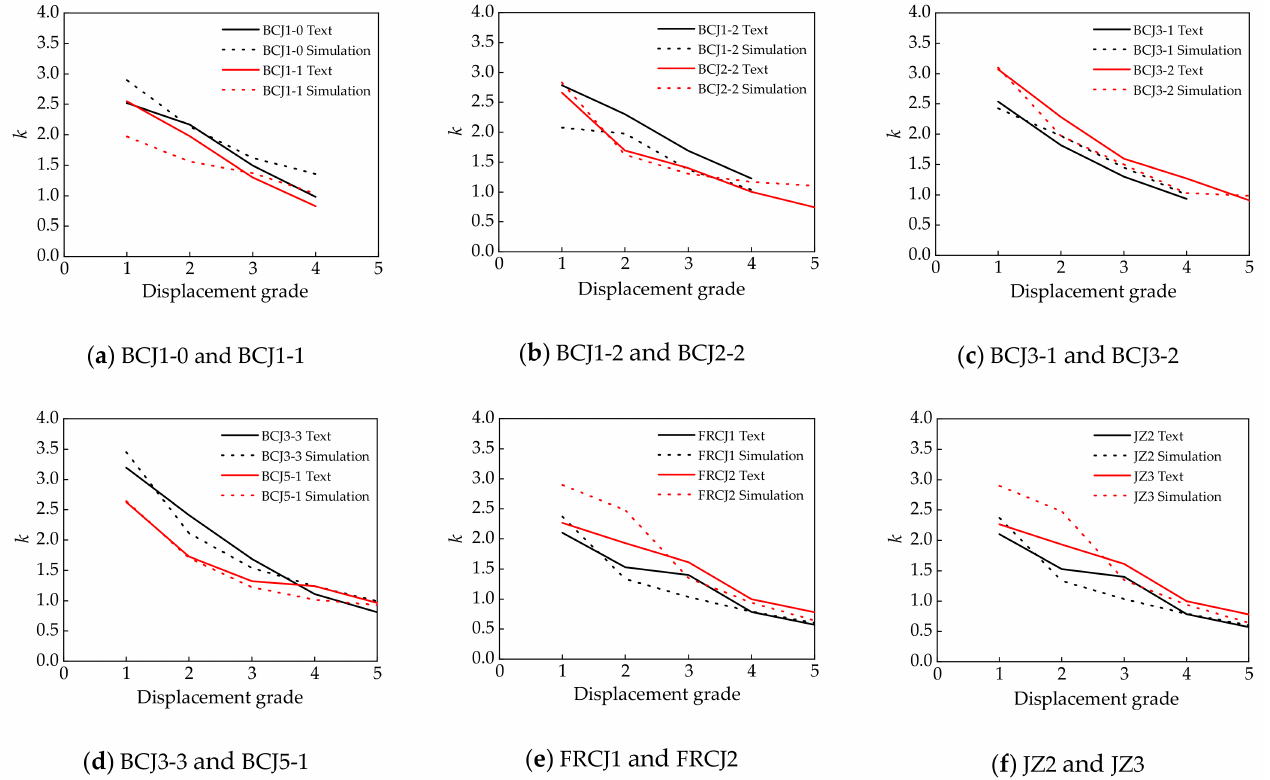
Figure 15. Relationship between stiffness degradation coefficient and displacement